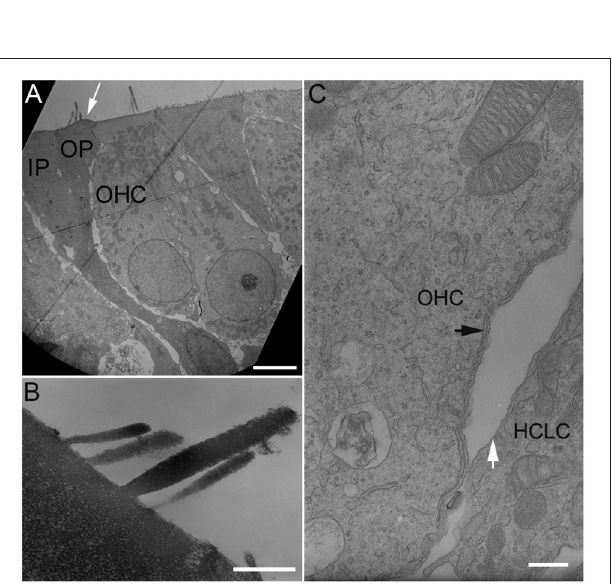
FIGURE 3 | Transmission electron microscopy (TEM) micrographs of hair cells and HCLCs. (A) Hair cells and a stereocilia bundle-bearing pillar cell. IP: Inner pillar cell. OP: Outer pillar cell. OHC: Outer hair cell. Bar: 5 µ m. (B) Stereocilia of an HCLC. Bar: 1 µ m. (C) Lateral walls of an OHC and an adjacent HCLC. Black arrows indicate one layer of subsurface cisternae underneath the plasma membrane of the OHC. A white arrow indicates the plasma membrane of an adjacent HCLC. No subsurface cisternae were seen. Bar: 0.2 µ m. obtained from control and DAPT-treated cultures (from low apical turn) are presented in Figure 4 . As shown in Figure 4A ,